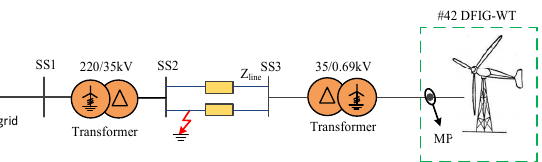
Figure 9. Wiring diagram of grid ‐ connected system of doubly fed wind turbine.